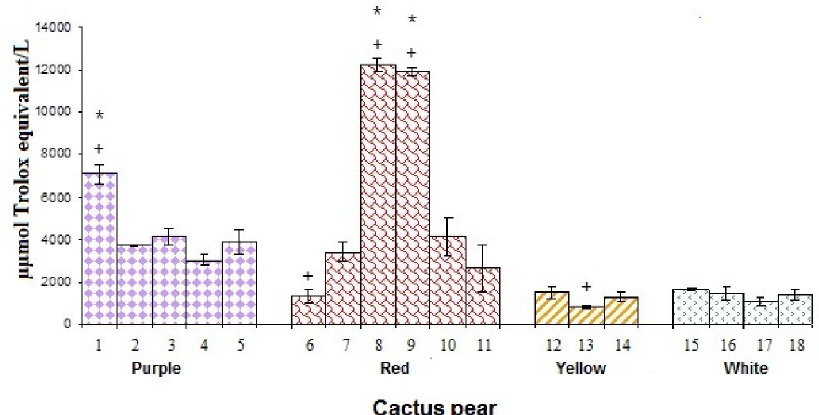
Figure 5. Antirradical activity of cactus pear studied cultivars. * denotes statistical significance at p < 0.05 among all studied cultivars of cactus pears. + indicates statistical significance at p < 0.05 among the cultivars of cactus pears in the same